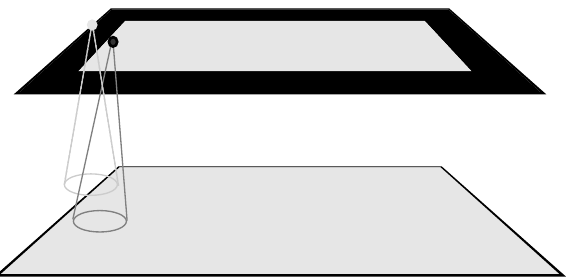
Figure 4. The basic reason for the boundary problem is illustrated. The lower rectangle depicts a retinotopic repre- sentation that is the input to the upper one. The left cone, whose bottom (input) straddles the lower layer, represents a convolution with insufficient data support, and the right one is a normal one with full support. The black border in the upper layer is the region that is undefined as a result. The width of the affected region in the feedforward direction is dependent on the half-width of the convolution In summary, a novel view of the covert-overt fixation